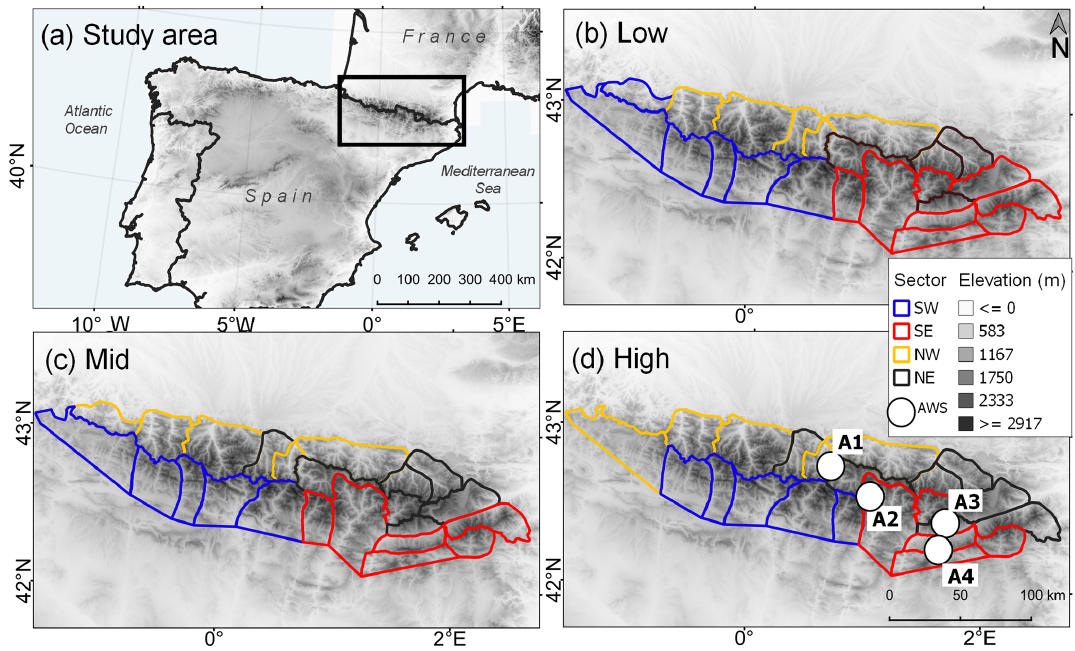
Figure 1. (a) Study area. Pyrenean massifs grouped by sectors for (b) low, (c) mid, and (d) high elevation. The white dots indicate the loca- tions of the automatic weather stations (AWSs) shown in Table 1. Massif delimitation is based on the spatial regionalization of the Système d’Analyse Fournissant des Renseignements Adaptés à la Nivologie (SAFRAN) system, which groups massifs according to topographical and meteorological characteristics (modified from Durand et al.,